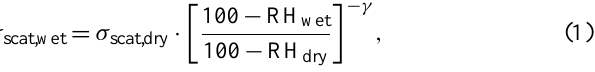
Table 1. DISCOVER-AQ flight dates including complete circuits over all six sites